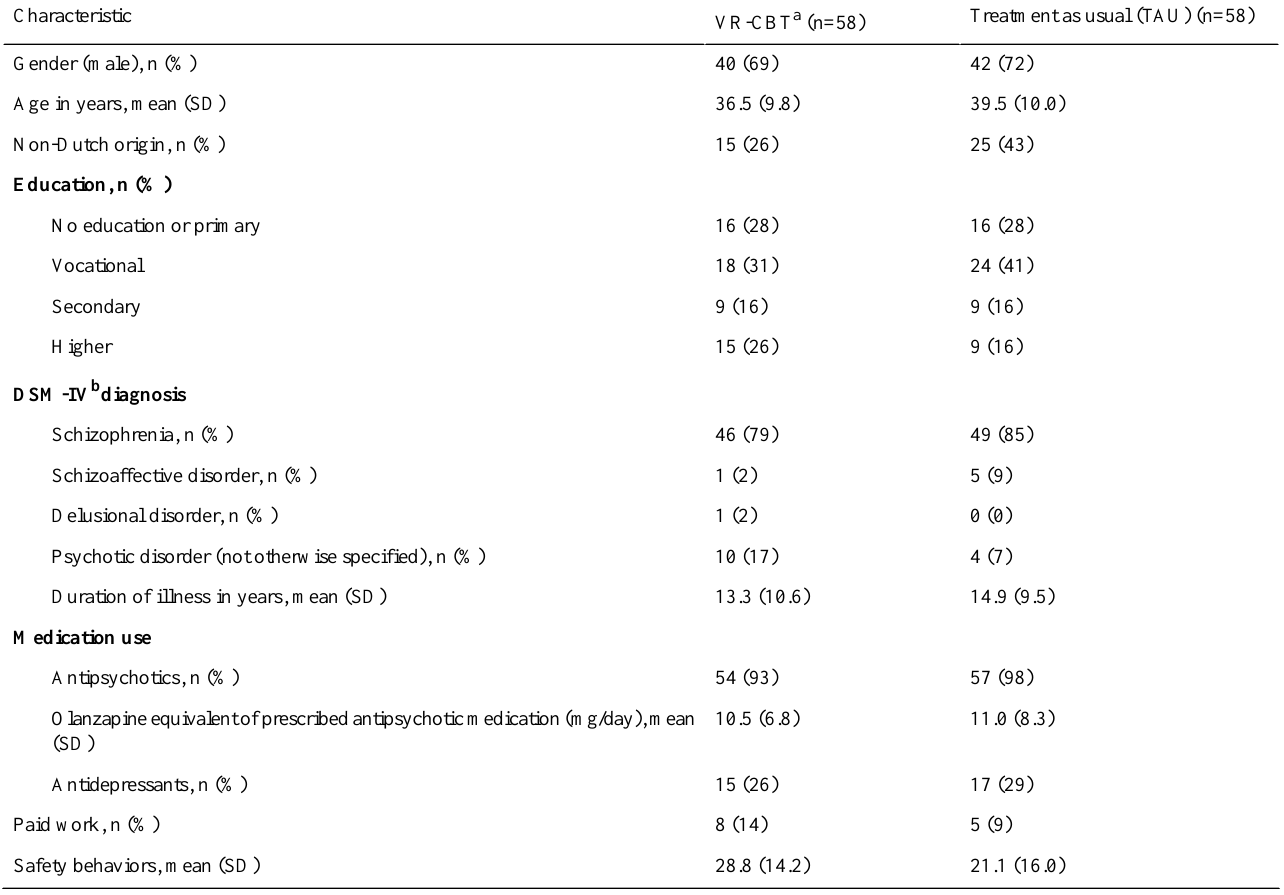
Table 1. Characteristics of the study sample at baseline.